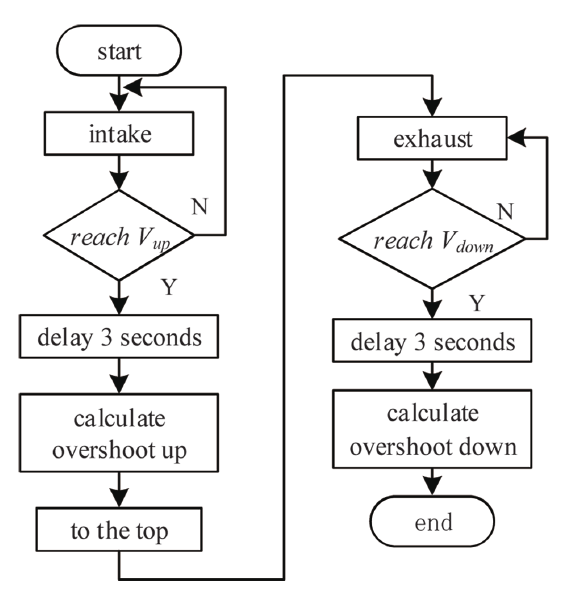
Figure 11. Self-identification flowchart for maximum speed and